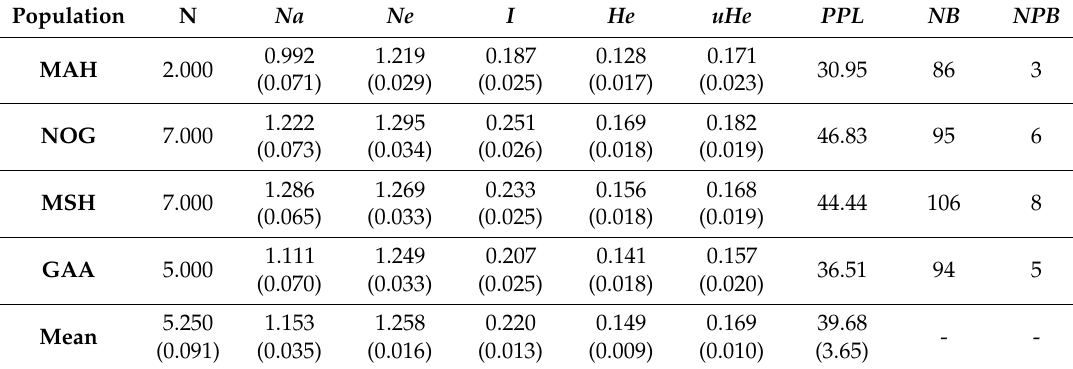
Table 6. Genetic indices among invasive A. franciscana populations according to ISSR